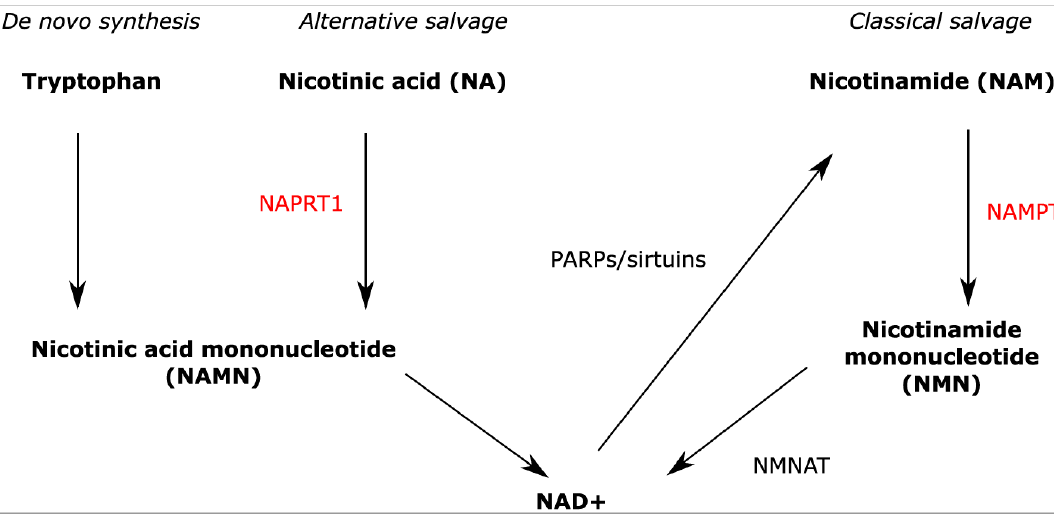
Figure 1. Simplified overview of the NAD+ synthesis pathway. NAD+ is synthesized by de novo synthesis, the alternative salvage pathway, or the classical salvage pathway. NAMPT and NAPRT1 are the rate-limiting enzymes of the classical salvage and alternative salvage pathways, respectively. NMNAT = Nicotinamide mononucleotide adenylyltransferase 1.